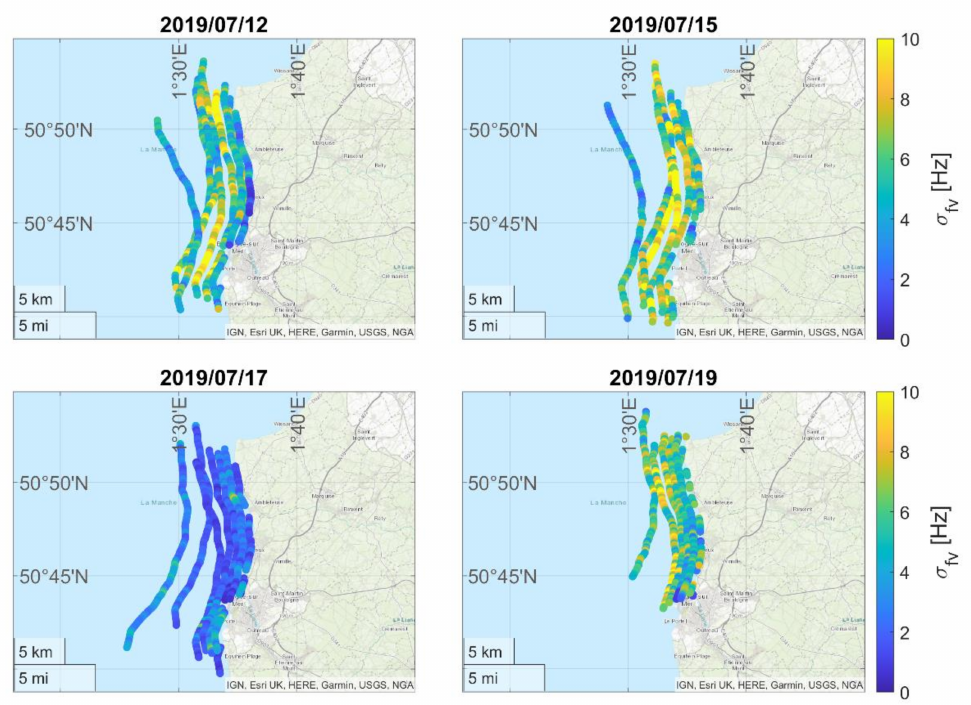
Figure 9. Mapped Doppler spread on the reflection point tracks of the eight GPS satellites analyzed along the coast for each day.